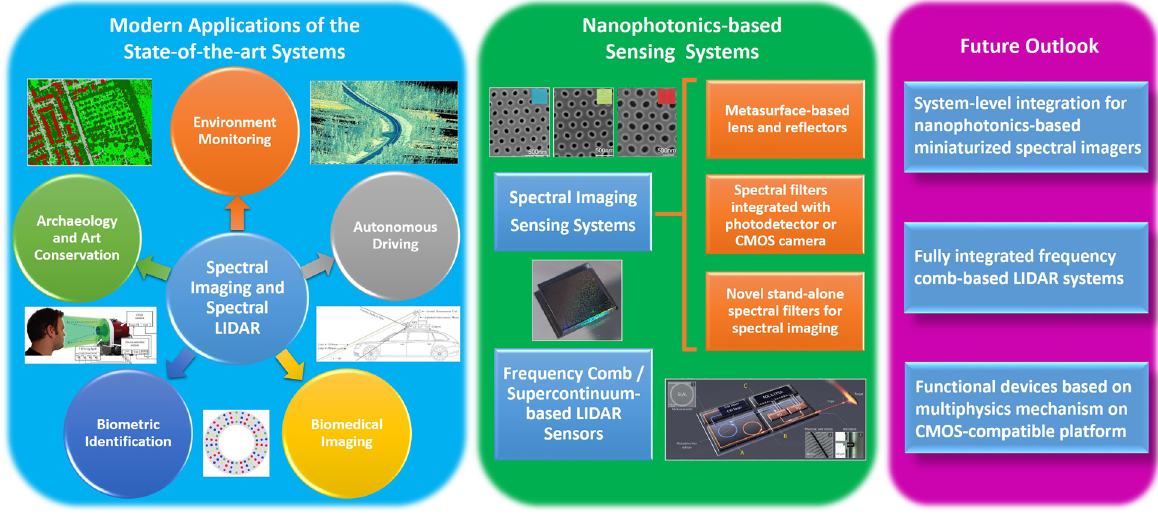
Figure 1: Overview of spectral imaging and spectral LIDAR systems, applications and future outlook. Left panel: Modern applications chart of the state-of-the-art spectral imaging and spectral LIDAR sensing systems. Inset images: (top left) 2 dimensional (2D) multispectral images of urban area, adapted with permission from the study by Morsy et al. [11]. Licensed under a Creative Commons Attribution. (top and bottom right) A point cloud captured by line-scanning LIDAR system and schematic of LIDAR measurement setup, both adapted from the study by Taher [18] with permission. Copyright Josef Taher, Finnish Geospatial Research Institute FGI. (bottom leftandmiddle)Schematicofmultispectralfacialrecognitionsystemsetupandlightsource,bothareadaptedwithpermissionfromthestudy by Steiner et al. [23]. Licensed under a Creative Commons Attribution. Middle panel: Nanophotonics-based sensing systems. Inset images: (top and middle) Scanning electron microscopy (SEM) images of the fabricated color fi lters and optical image of color fi lters integrated with detectorarray, both are adapted with permissionfrom the study by Shah et al. [33]. Licensed undera CreativeCommons Attribution. (bottom) Schematicofdual-comb-basedLIDARsystem,adaptedfromthestudybyTrochaetal.[34].ReprintedwithpermissionfromAAAS.Rightpanel: Outlook of the future development work for compact spectral imaging and LIDAR sensing